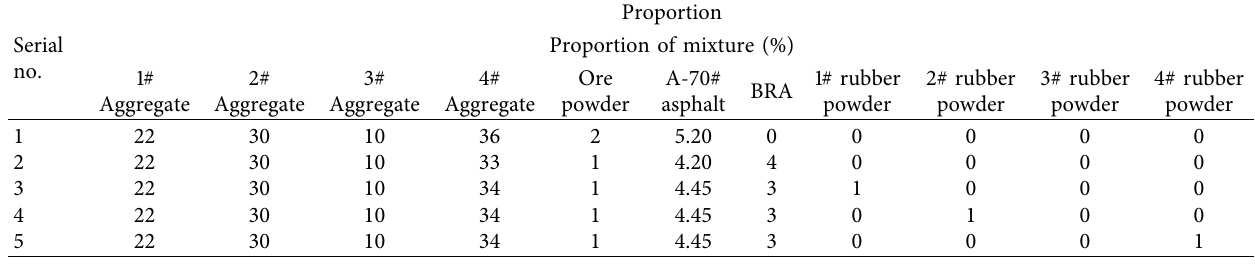
Table 2: Proportion of modified asphalt mixture.